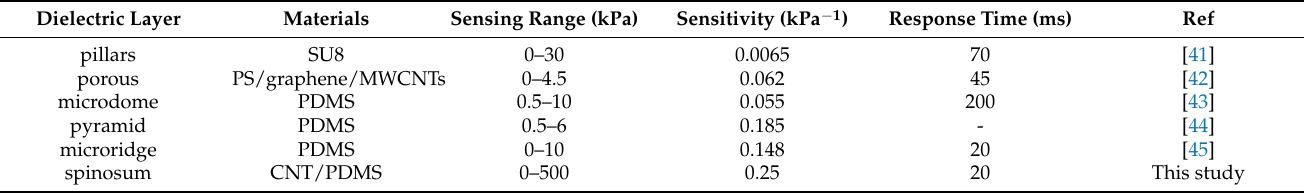
Table 1. Comparison of the performance between our work and recently reported flexible capacitive pressure